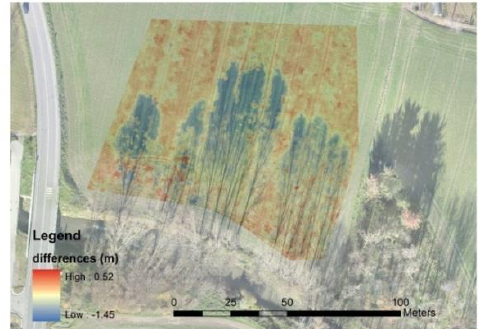
Figure 8 – Differences of DSMs (P4-AP): detail in shadow area produced from trees